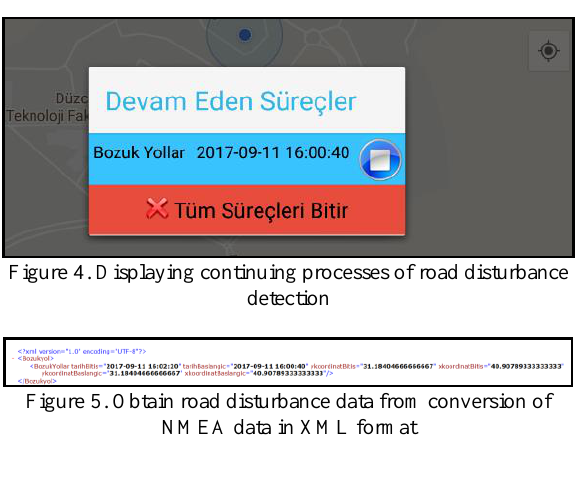
Figure 5. Obtain road disturbance data from conversion of